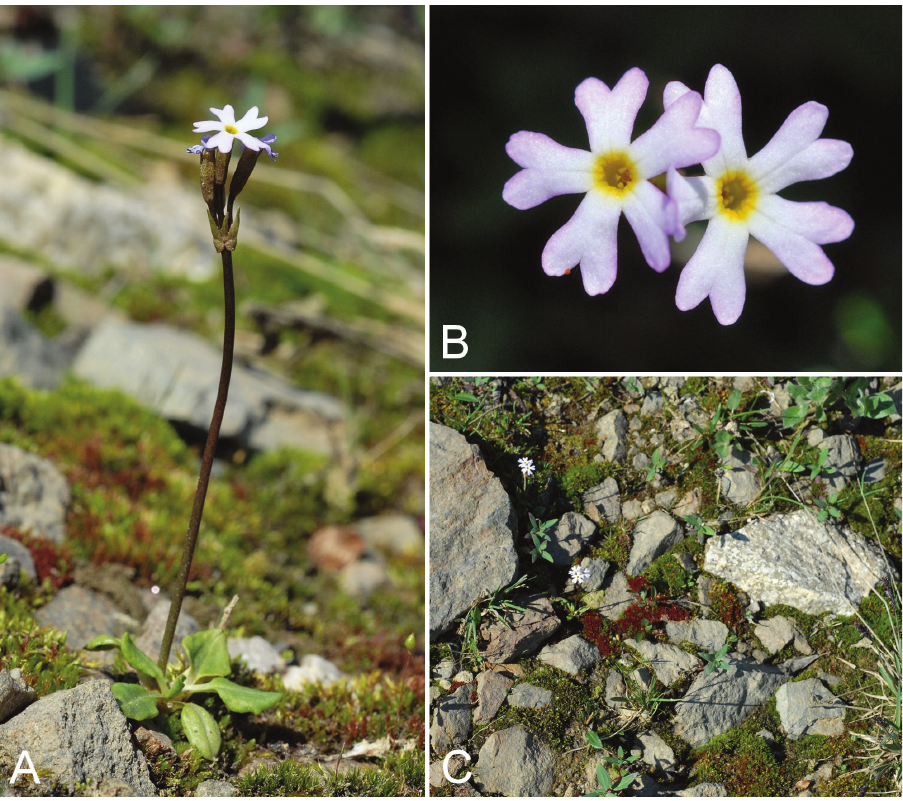
Figure 17. Primula egaliksensis : A habit B inflorescence C habitat, Saarela et al. 2606 . Photographs by L.J. Ranunculaceae Coptidium × spitsbergense (Hadač) Luferov & Prob. Fig. 18 Ranunculus × spitsbergensis Hadač Common name. Spitzbergen buttercup Distribution. Disjunct circumpolar Comments. Our collections are the first of this species for the CAA. The spe- cies is considered to be a sterile triploid hybrid between Coptidium lapponicum (L.) Rydb. and C . pallasii (Schltdl.) Tzvelev, and exhibits an intermediate morphology and habitat preference (Cody et al. 1988, Elven and Murray 2008). All three species were previously treated within Ranunculus L. (Porsild 1957, Porsild and Cody 1980, Cody et al. 1988, Whittemore 1997, Aiken et al. 2007), but they differ both genetically